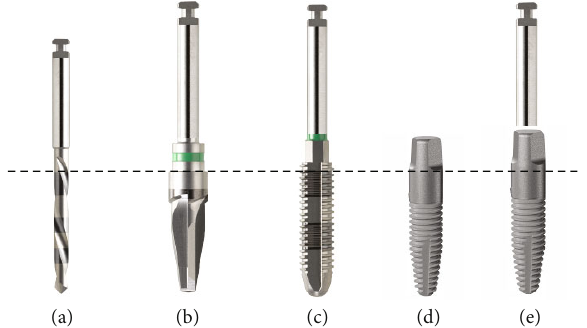
Figure 2: (a) Predrilling instrument ø 2.0mm; (b) shaping-drill with conical design for bone harvesting during preparation, variable diameter and length; (c) thread cutter (optional); (d) one- piece implant (FairOne ™ ) with self-tapping thread; (e) overlapping view of shaping-drill with corresponding tapered design of the FairOne ™